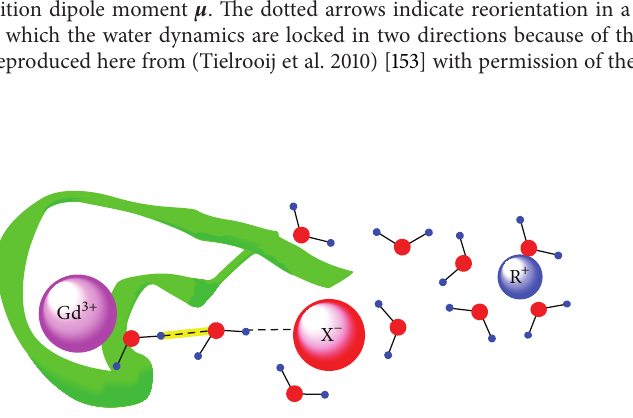
Figure 2: Depiction of how Gadolinium (Gd 3+ ) vibronic side band luminescence spectroscopy (GVSBLS) acts as a probe of the coordination of biologically-relevant sites of cation sequestration. The figure is reproduced here from (Guo and Friedman 2009) [139] with permission of the American Chemical Society. Copyright 2009 American Chemical